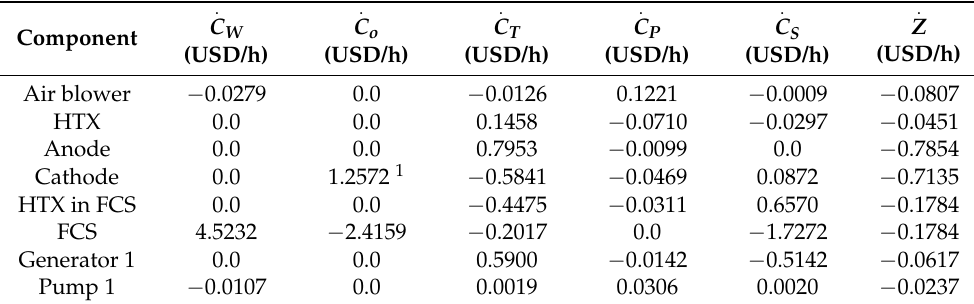
Table 4. Cost flow rates of various exergies and lost cost flow rate of each component in hydrogen- fueled 5-kW PEMFC system.